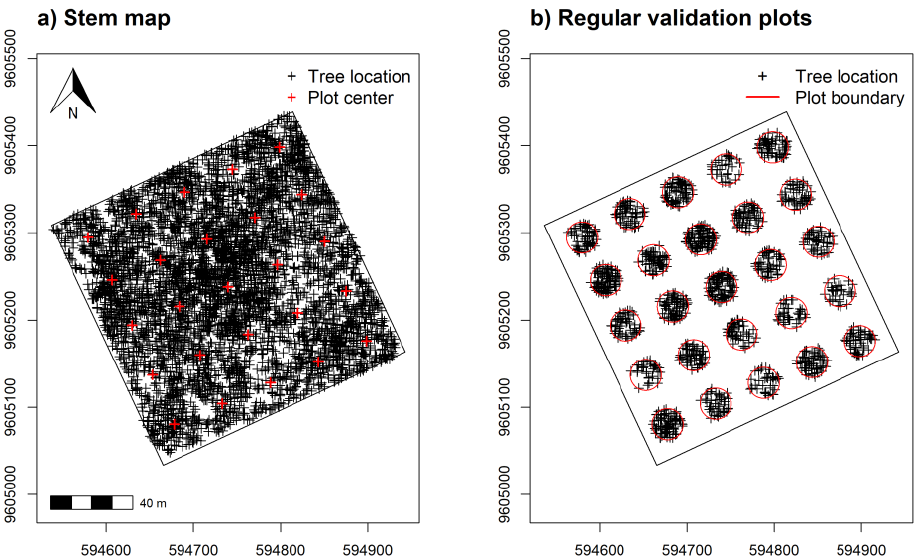
Figure 3. Stem mapped tree species ≥5 cm DBH from ( a ) across the sampling area and ( b ) within simulated 0.10 ha validation plots regularly spaced at 60 m apart for assessing α-diversity model predictions. Tree location UTM coordinates in ( a ) with height and elevation measurements were also used to develop tree canopy height and elevation models.